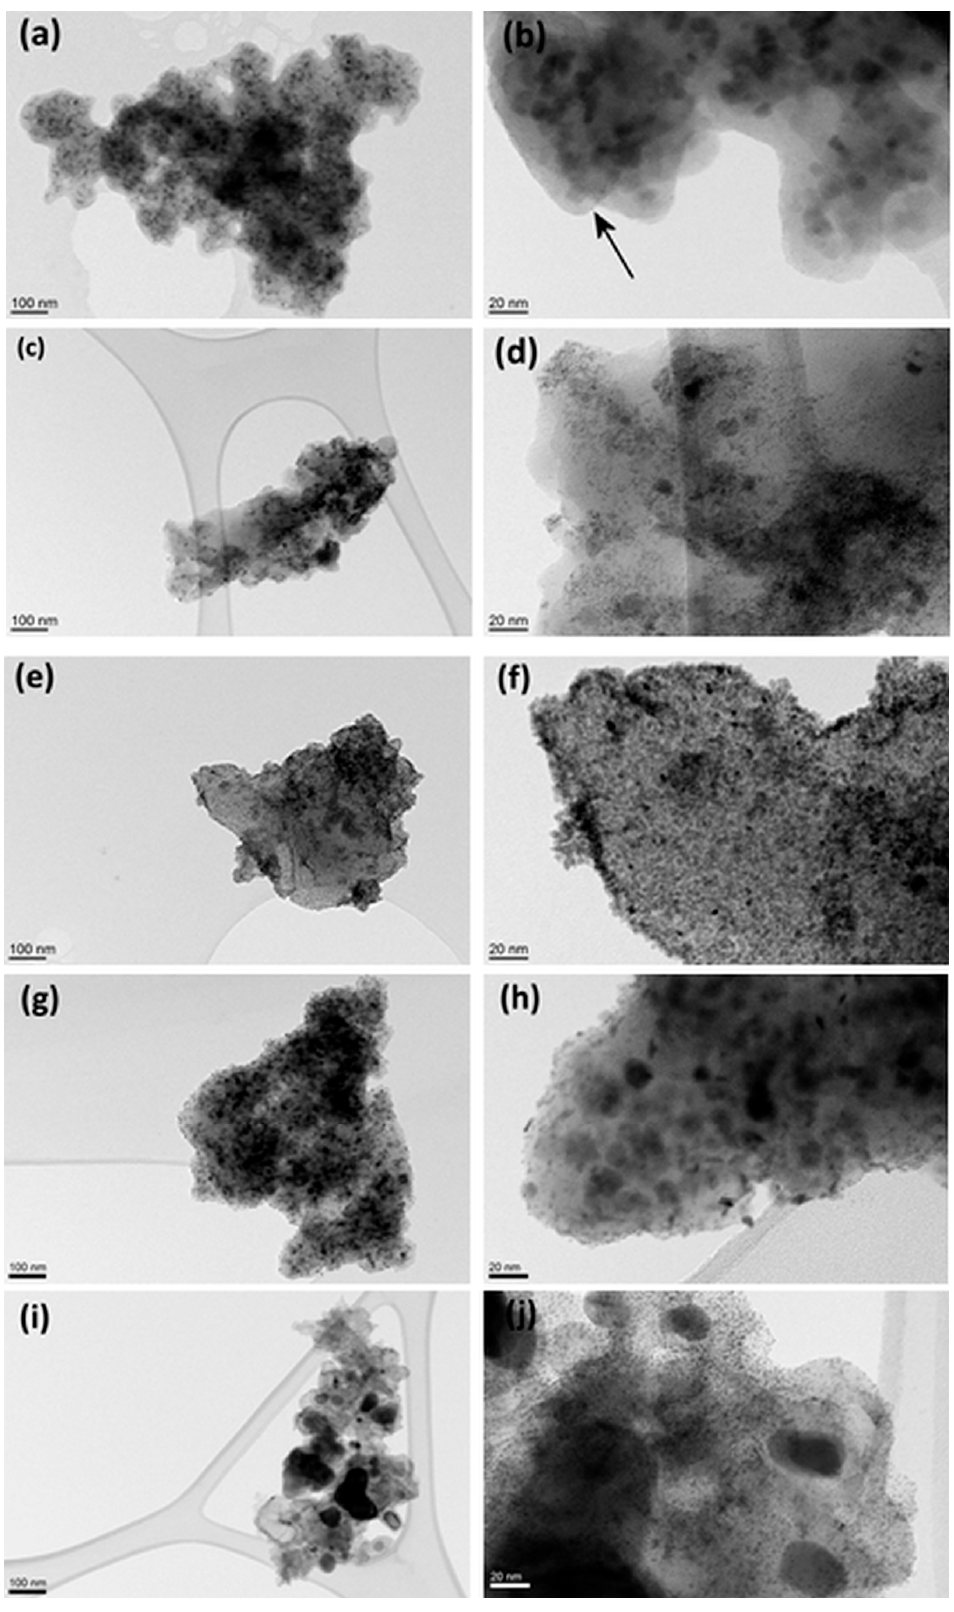
Figure 2. Transmission electron microscopy (TEM) images of catalysts ( a , b ) Ru/C-Fe 2 O 3 , ( c , d ) Ru/C-Fe 2 O 3 -300, ( e , f ) Ru/C-Fe 2 O 3 -500, ( g , h ) Ru/C-Fe 2 O 3 -600, and ( i , j ) Ru/C-Fe 2 O 3 -750. An Ru nanoparticle is marked with the arrow ion the image (b).